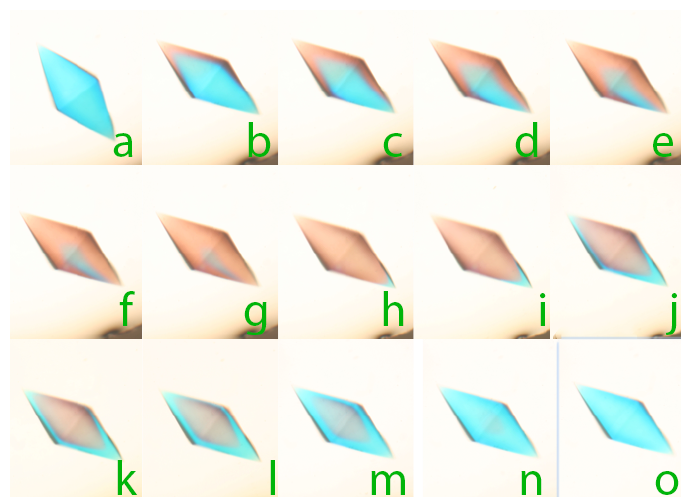
Figure 10. A tetragonal crystal of thaumatin was saturated with the copper porphyrin dye Luxol blue (Solvent blue 38) in ( a ) and dithionite then added to the mother liquor ( b ). The blue color transitioned to elemental copper as the dye was reduced. At about ( k ) oxygen from the environment began to re-oxidize the copper to the Cu 2+ state and the dye regained its blue color. In both the reduction and oxidation phases the redox front was well defined. The series of images ( a – o ), taken at appropriate time intervals, shows the progress of the dye.